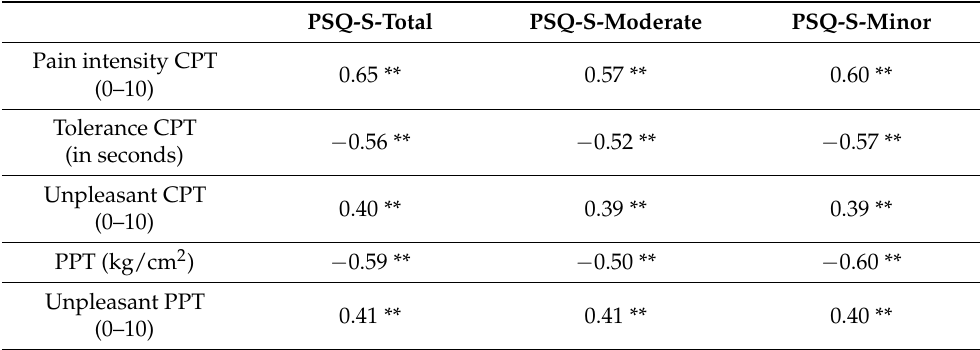
Table 4. Correlations between PSQ-S scores and single experimental pain rating parameters ( n =